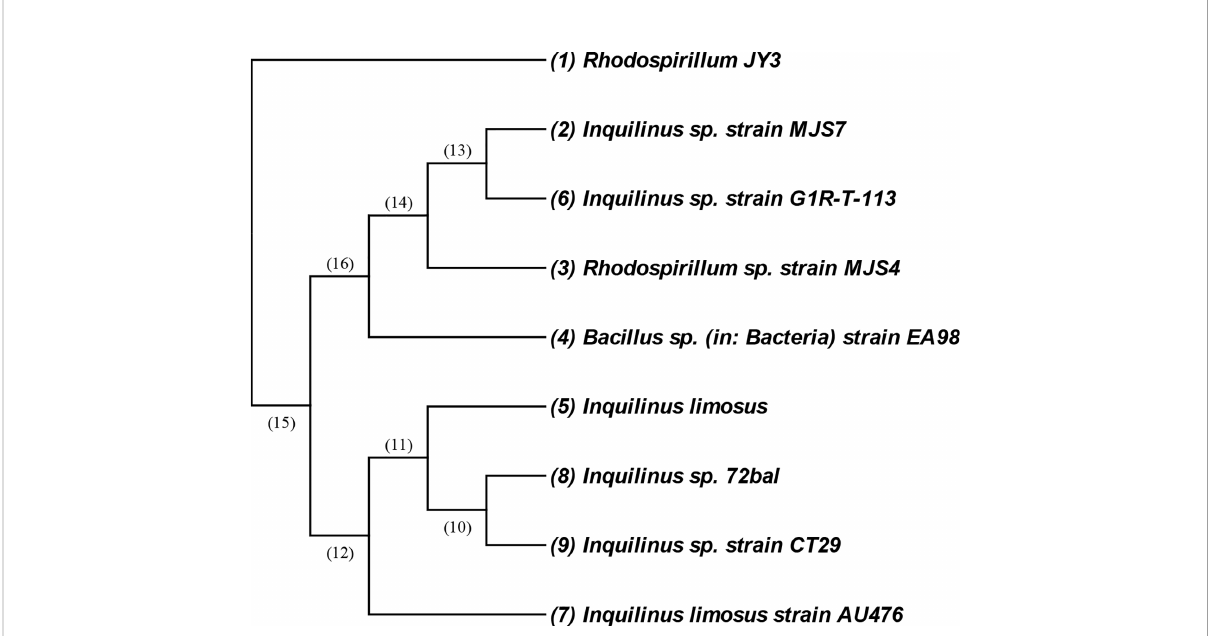
FIGURE 1 An ampli fi ed 16S rRNA gene fragment from the isolated JY3 was sequenced and blast searched through the NCBI database. Closely related sequences were downloaded and aligned using MEGA. The isolate of JY3 was presented in the same clade with Rhodospirillum sp. strain MJS4 16S ribosomal RNA gene, partial sequence